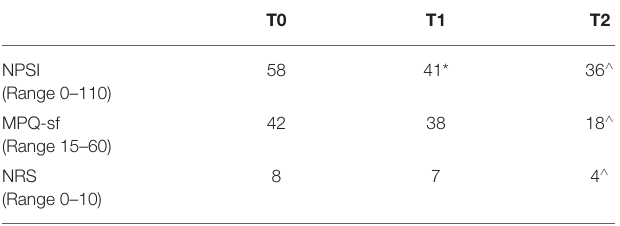
TABLE 1 | Clinical results at the three time points: 40 days after the right thalamic stroke (T0), immediately after the last repetitive transcranial magnetic stimulation (rTMS) treatment session (T1), and one month after the last rTMS session (T2). T0 T1